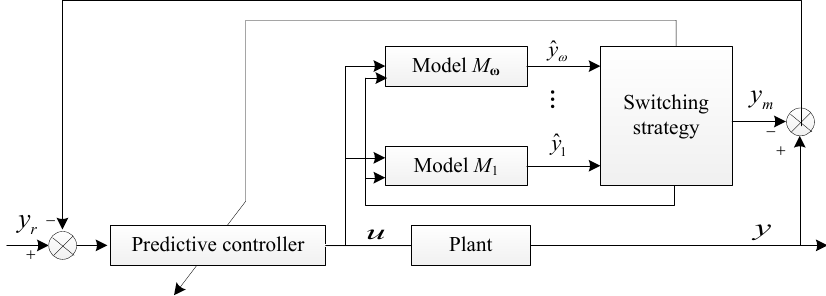
Figure 1. Structure diagram of the multi-model predictive control (MMPC) system.